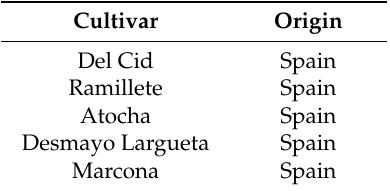
Table 1. Panel of cultivars genotyped in this study.